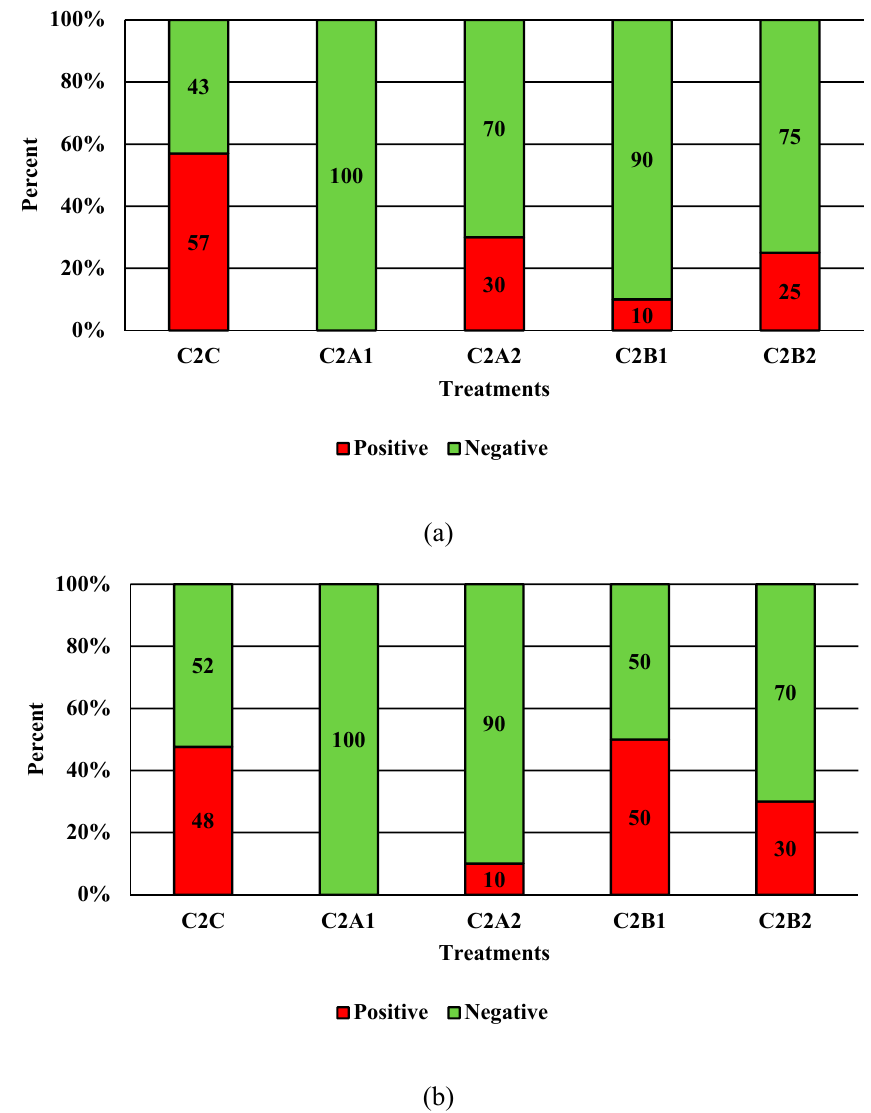
Figure 7. The effect of Competitor 2, a peracetic acid sanitizer used as an antimicrobial dip (400 and 600 ppm) and in a stationary chilling tank (25 and 45 ppm) on the prevalence of Salmonella ( a ), and Campylobacter ( b ) present in the rinsates of 42 d old Ross 708 broilers. N = 50, n = 10, p < 0.0001 ( a ); N = 50, n = 10, p < 0.0001 ( b ).